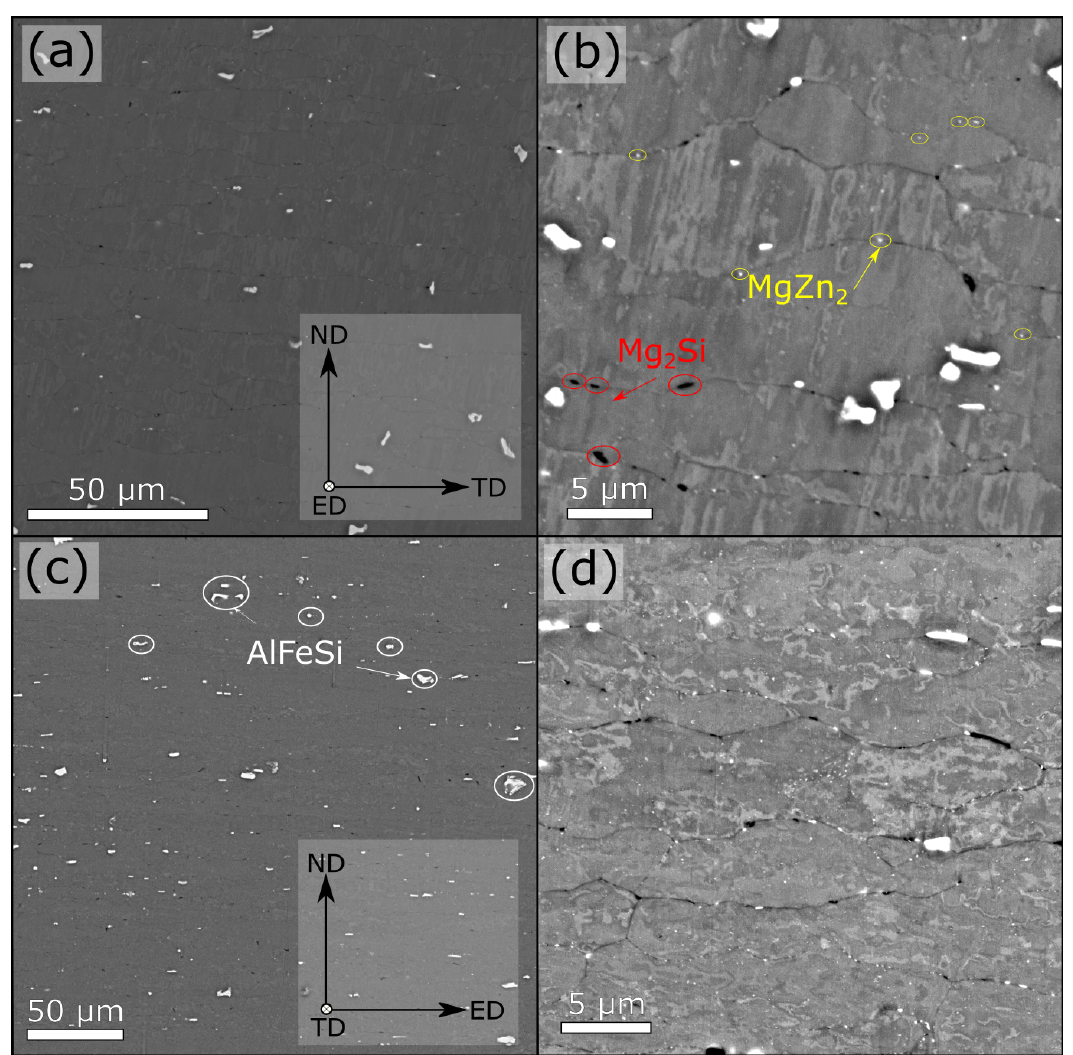
Figure 3. Representative BSE-SEM images from sample H-AC-T6, acquired both parallel ( a , b ) and normal ( c , d ) to the extrusion direction. Large Al-Fe-Si containing primary particles can be seen in ( a , c ), and tiny η -MgZn 2 particles are visible on the grain boundaries in ( b , d ). The black regions on the grain boundaries in ( b , d ), are β -Mg 2 Si particles, which are only present in air-cooled